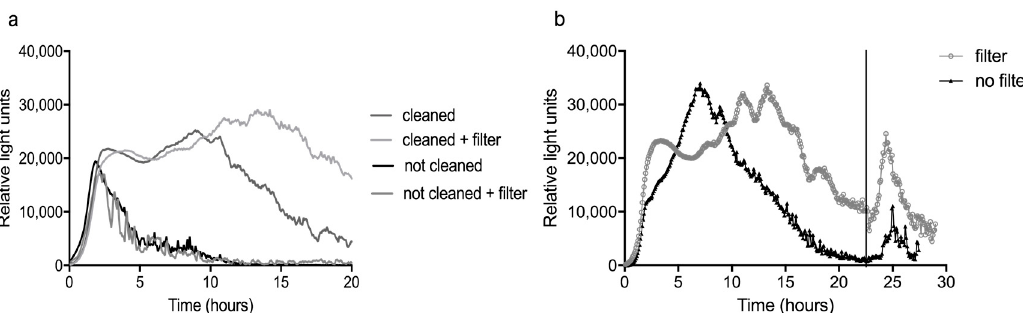
Figure 7. The effect of filtration on the response of the bacteria is shown. These experiments were performed with tap water in the laboratory. In ( a ) the background response is compared in both a cleaned sensor and when the sensor was used on subsequent days without cleaning in between and with and without the addition of a filter before the water inlet. The curves of the cleaned sensor are averages of three measurements, those of the not cleaned sensor single measurements. In ( b ) the bacteria were exposed to 1 mg/L nalidixic acid after 22.5 h, for one hour (moment indicated by the vertical line), with and without a